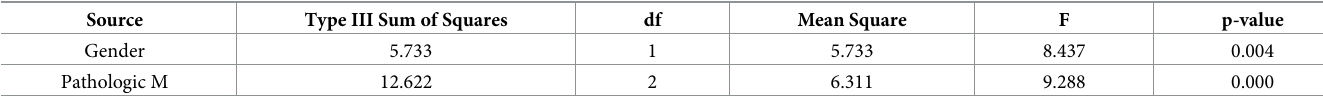
Table 2. Clinical multivariate data related to ADARB1 expression in LUAD.